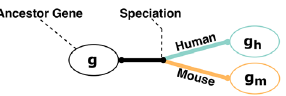
Figure 2. Speciation of an ancestor gene g into two genes g h and g m . g h and g m are